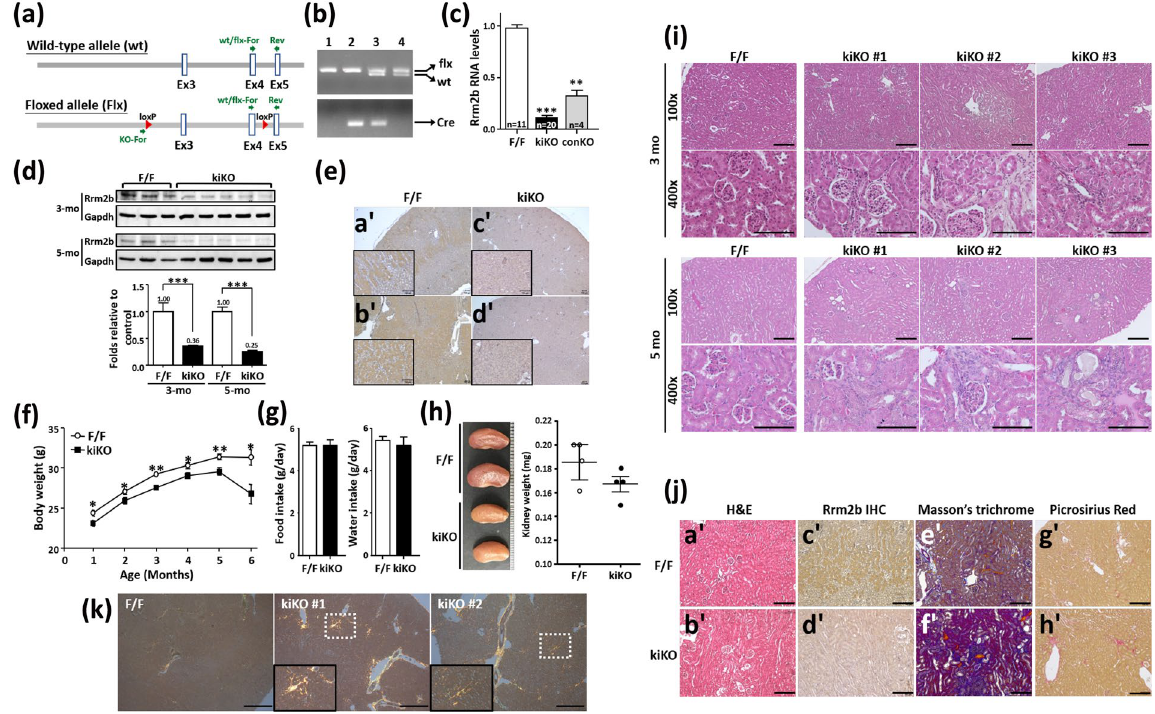
Figure 1. Physical characterization of Rrm2b kidney-specific knockout mice. ( a) The location of two loxP sites in cis and the primers for genotyping to verify Rrm2b floxed, wild-type and knockout allele. (b) Genotyping of floxed and wild-type alleles using PCR. Genotype of sample 1 was wild-type ( + / + ); genotype of sample 2 was Cdh16-Cre/ + ; genotype of sample 3 was Rrm2b kiKO (Rrm2b flx/flx;Chd16-Cre/ + ); genotype of sample 4 was Rrm2b flx/flx (F/F). (c) Quantitative real-time PCR analysis of Rrm2b in kidney from Rrm2b kiKO and control (F/F) mice. conKO, Rrm2b conventional knockout mice. (d) Western blot analysis of Rrm2b in kidney from Rrm2b kiKO and control (F/F) mice. Quantification of western blot analysis by Image J software. (e) IHC staining of Rrm2b in kidney from Rrm2b kiKO and control (F/F) mice. Mouse age in ( c–e ), 2 months old. Scale bar, 100 μ m. (f) Examination of body weight. The data were collected from 1- to 6-month-old male mice (n = 8–30 per group). (g) Food and water intake were monitored using metabolic cages. A total of 10 mice from each group were used for experimentation. (h) Gross view and quantified mass of kidneys from Rrm2b kiKO and F/F (control) mice. (i) H&E staining of kidneys from F/F (control) and Rrm2b kiKO mice. (j) Collagen accumulation was observed with Rrm2b deletion: (a’,b’) H&E staining, (c’,d’) Rrm2b IHC staining, (e’,f’) Masson’s trichrome staining, (g’,h’) Picrosirius Red staining. (k) Polarization contrast of the photos stained with picrosirius red. Enlarged view indicated the collagen-accumulated positions. Mouse age, 5–6 months old. Scale bar, 100 μ m. The results are presented as the mean ± SD. * p < 0.05; ** p < 0.005; *** p <